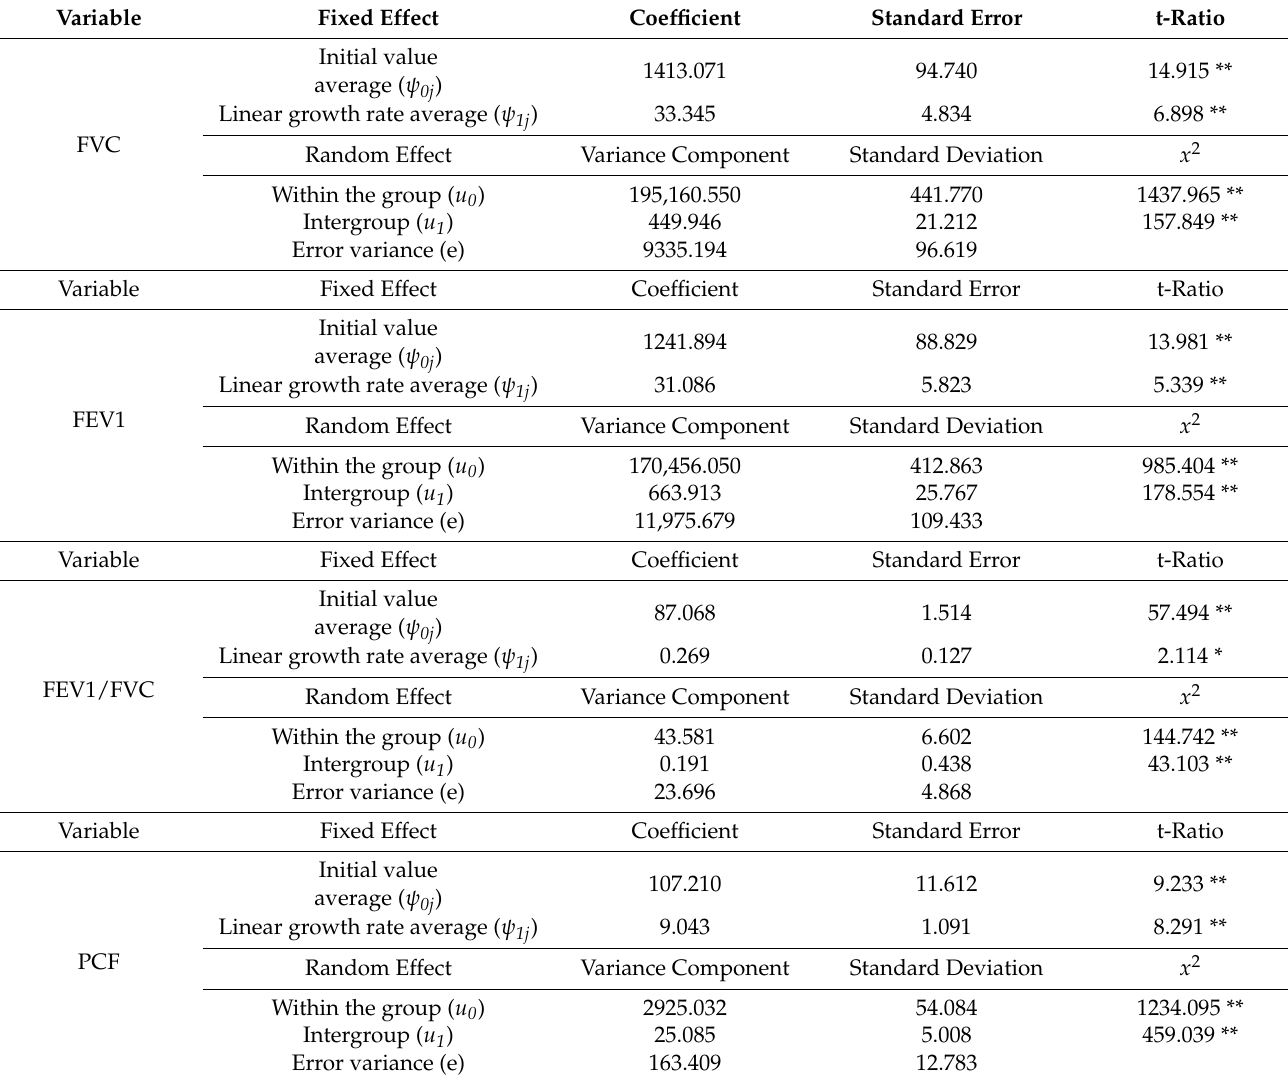
Table 6. Changes in respiratory function exhibited by the entire